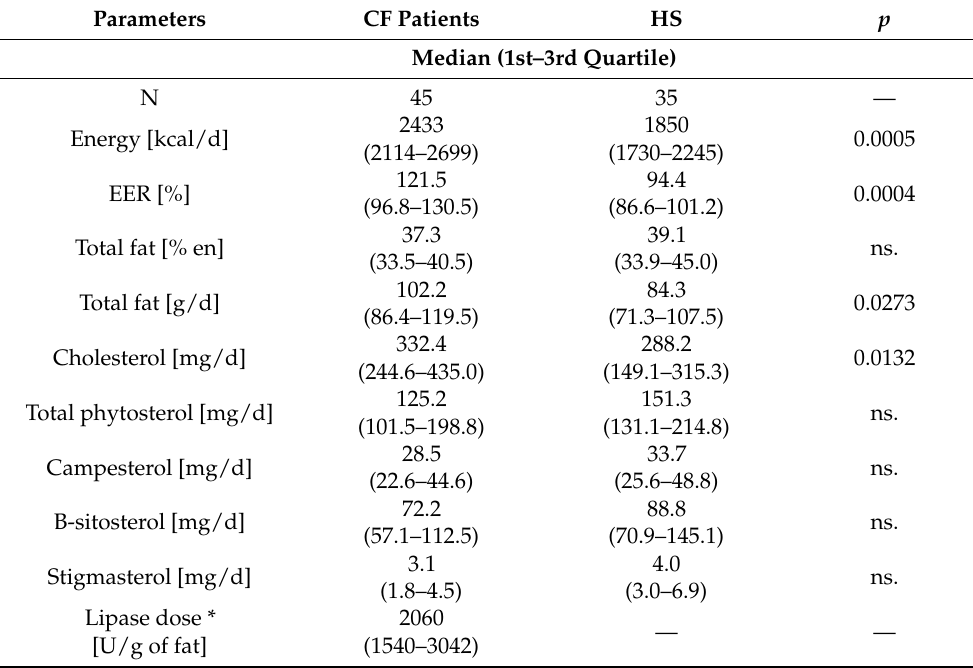
Table 3. Dietary intakes in cystic fibrosis (CF) patients and healthy subjects (HS).